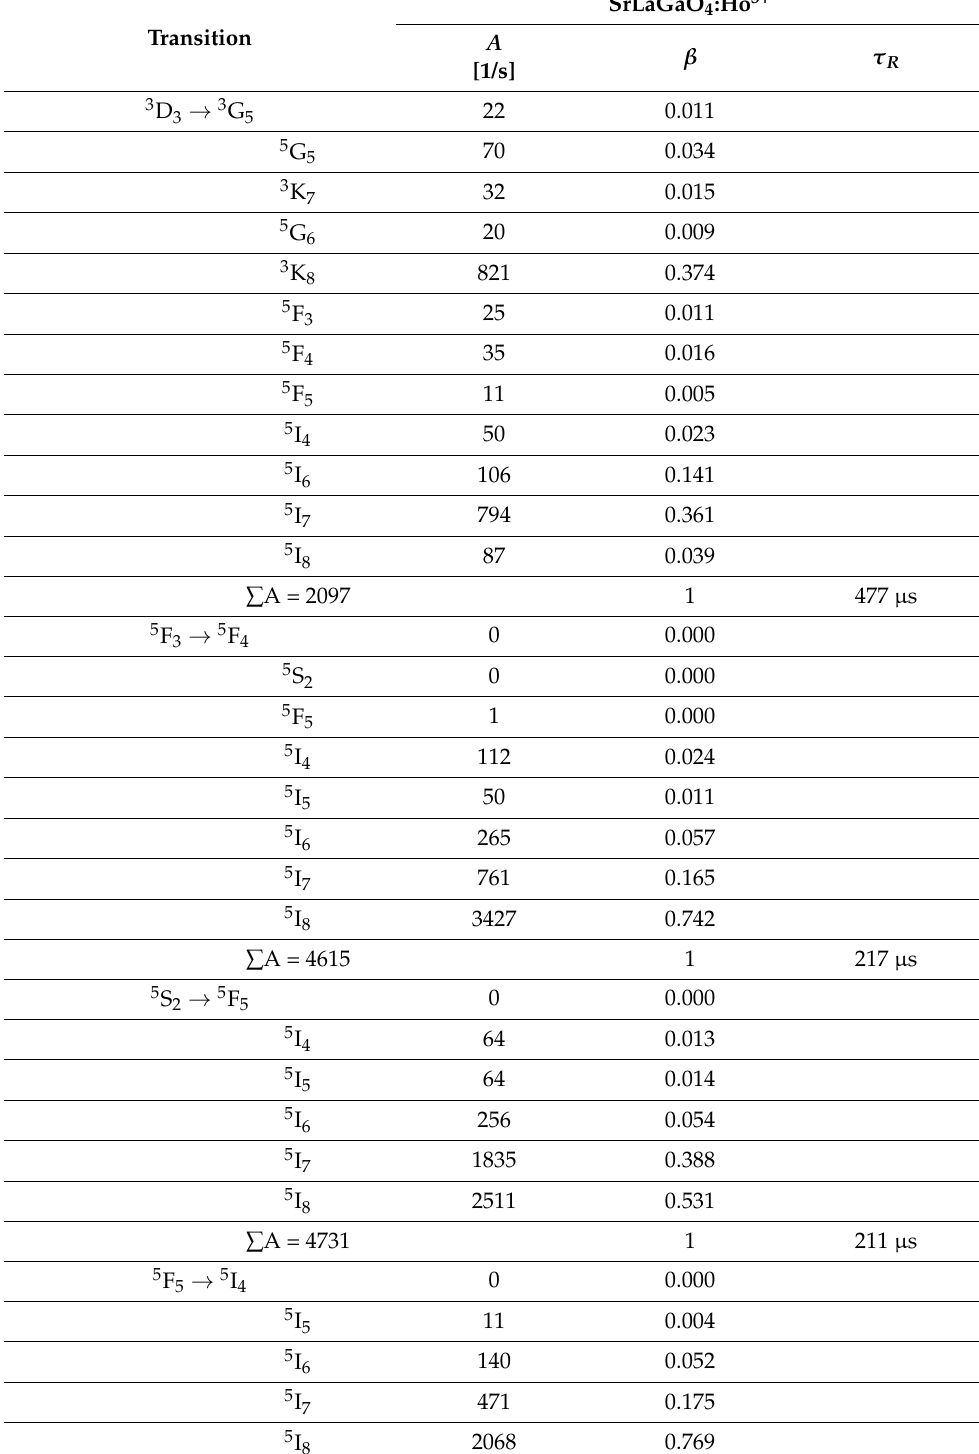
Table 3. Probabilities of radiative transitions, branching ratios and radiative lifetimes of excited states of Ho 3+ in SrLaGaO 4